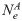
Effective population size and sex-bias.(A) Expected autosomal (NeA) and X-chromosomal (NeX) effective population sizes as a function of the proportion females (p) for N = 1000 individuals. When p = 0.5, there is no sex-bias, as denoted by the gray line. (B) The ratio of X-chromosomal to autosomal effective sizes, NeX/NeA, increases with p. This ratio is 0.75 when there is no sex-bias (p = 0.5, gray line) and is undefined when p is 0 or 1. (C) Inset of A: when p is greater than 0.875 (to the right of the gray line), NeX is greater than NeA, so NeX/NeA is greater than 1.